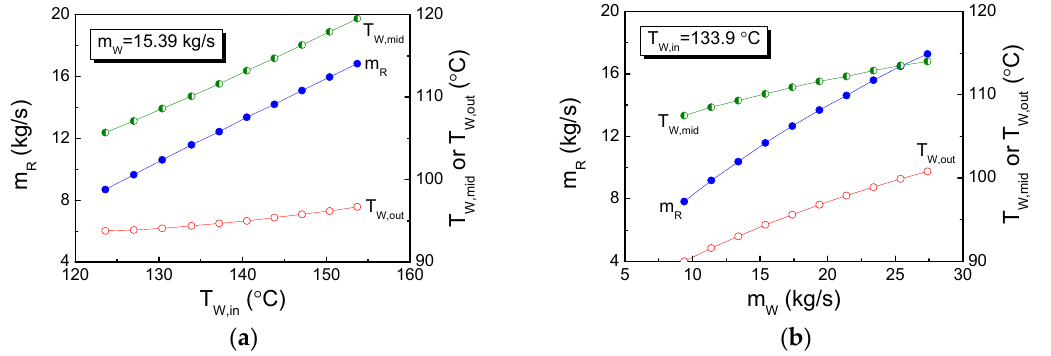
Figure 2. Operating flow rate of R245fa and temperature distribution of the hot stream as functions of ( a ) T W,in and ( b ) m W .